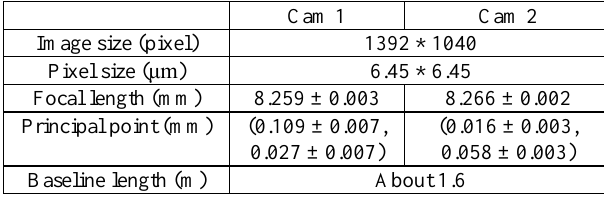
Table 1. Priori information of 2 forward cameras on MMS